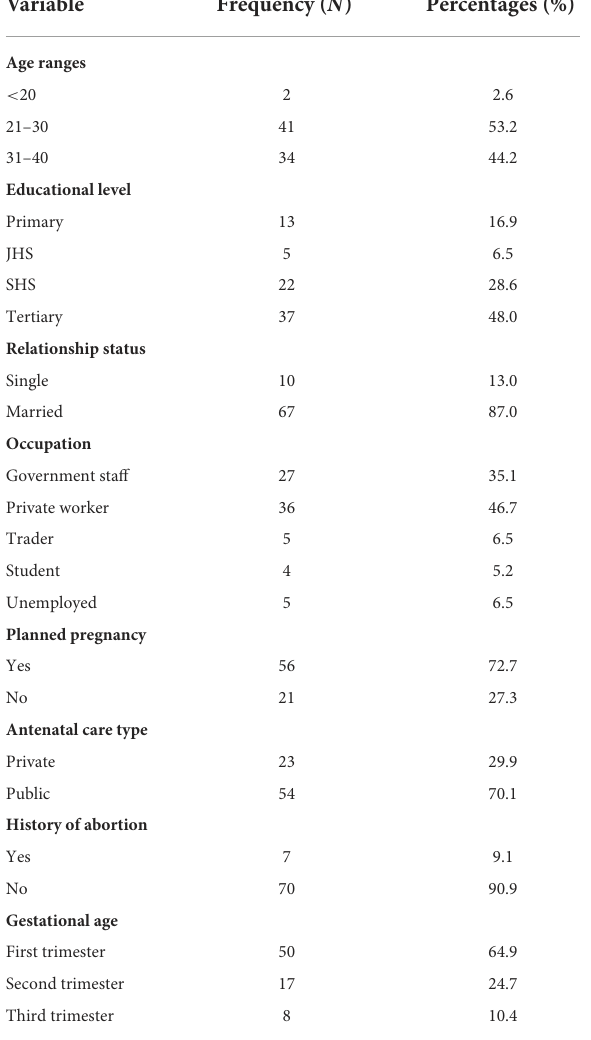
TABLE 1 Profile of participants by age, educational level, relationship status, occupation, planned pregnancy, antenatal care type and history of abortion ( n =